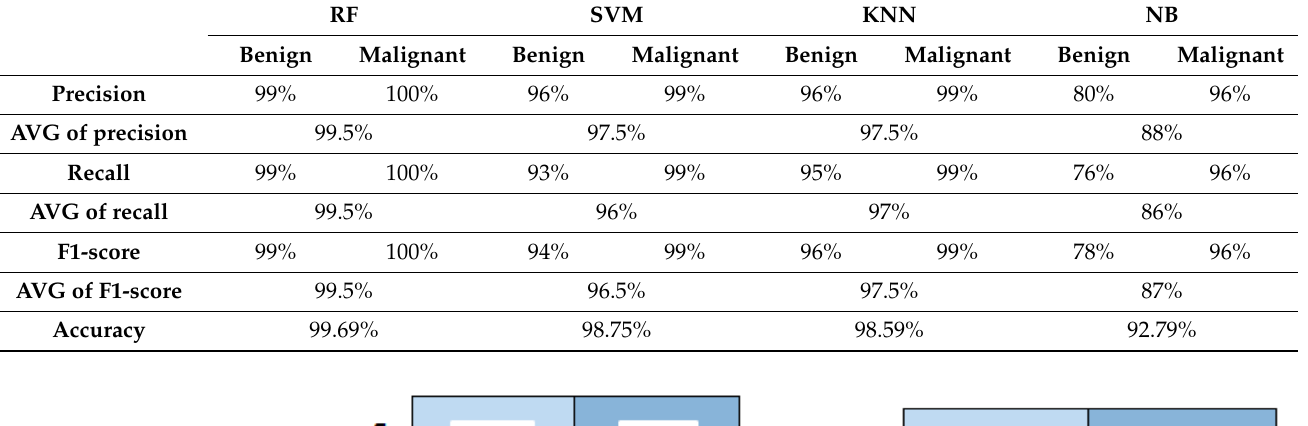
Table 5. The performance metrics for different classification techniques after using grey wolf opti- mization algorithm.